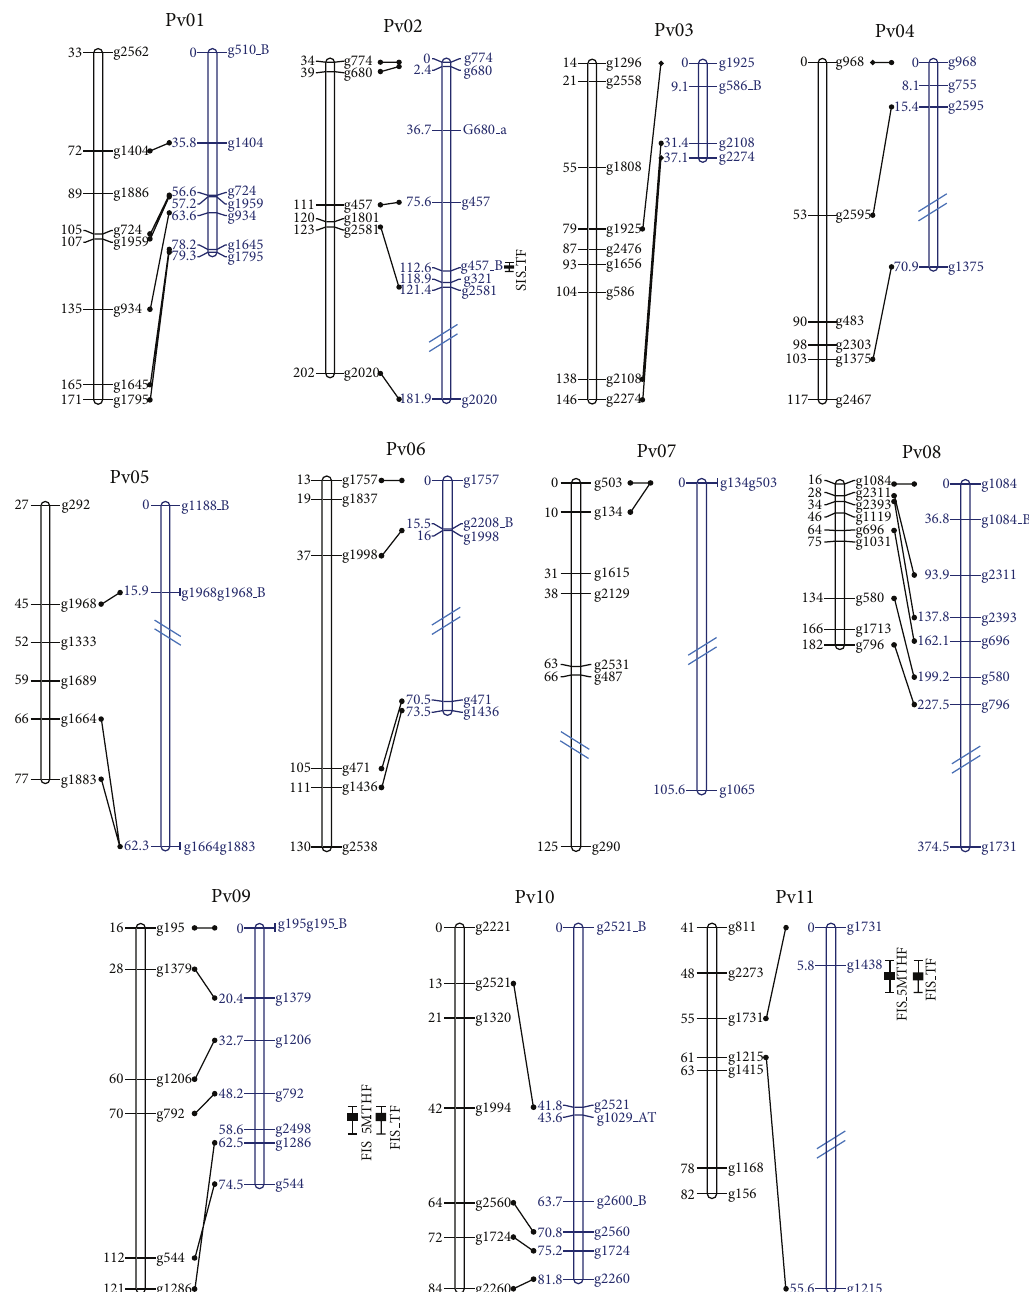
Figure3:AlignmentcomparisonofOthello × Redhawksinglenucleotidepolymorphicmarkermap(Linkagegroupontheleft)withreference map (Linkage group on the right). The diagonal double-lines on the linkage groups represent the intervals with higher than 50 cM distance between pairs of adjacent markers. Approximate position of the QTL for total folate (FIS-TF) and 5-Methyltetrahydrofolate (FIS-5MTHF) in the first injected solution, and total folate in the second injected solution (SIS-TF) have been identified on the map. The hatched lines on the linkage groups identify the intervals with more than 50cM genetic